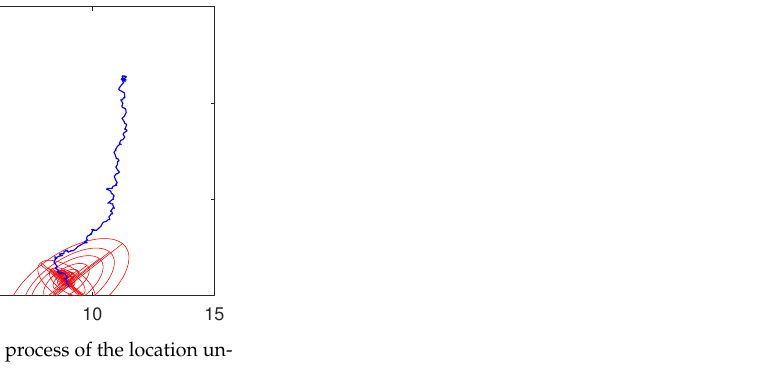
Figure 8. The minimization process of the location uncertainty. Blue lines represent the flight trajectory of the UAVs. The red ellipses represent the corresponding depict of the location uncertainty in each step.